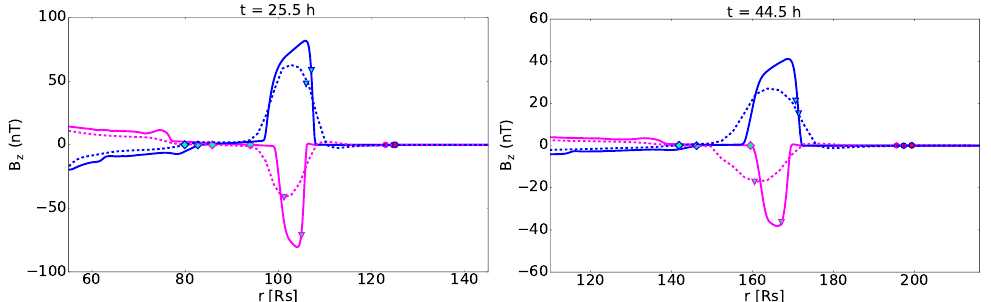
Figure 13. Logarithmic number density for normal and inverse CMEs for a cross section in the equatorial plane 25.5 h ( left ) and 44.5 h ( right ) after ejection. Magenta and blue lines represent normal and inverse CMEs, respectively, while full and dashed lines represent with and without AMR, respectively. The location of the shock is represented by green dots, the edge of the magnetic cloud by green triangles and the centre by green diamonds. The edges of these markers have the same colour as the curve on which they are located.